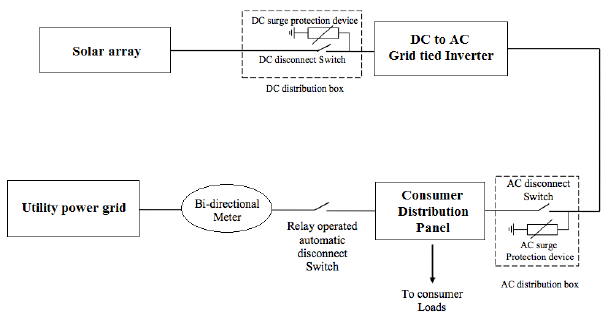
Figure 3. Working diagram of the typical grid-tied PV